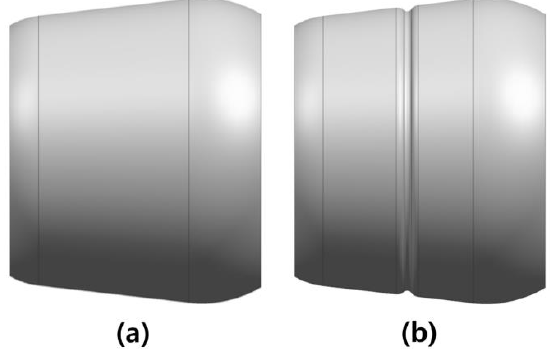
Figure 2. Three-dimensional models of: ( a ) a smooth expansion ball; and ( b ) grooved ball with a lubricant groove on its surface for Al tube expansion experiments.